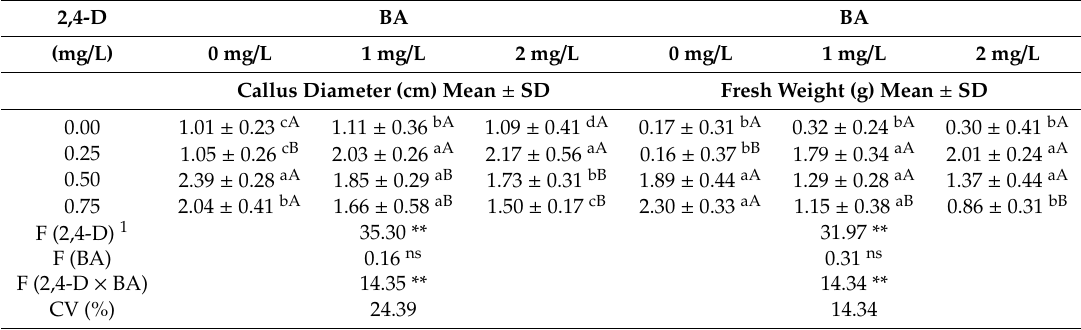
1 Each mean represents 10 replicates (test tube) with one nodal segment each. Means within a column (2,4-D e ff ects; lowercase) or lines (BA e ff ects; uppercase) followed by di ff erent letters are significantly di ff erent according to the Scott-Knott test at the 1% (**) level of probability. All data followed a normal distribution according to the Shapiro-Wilk test. SD = standard deviation of means; F = distribution of variances according the F test; CV = coe ffi cient of variation; ns = not